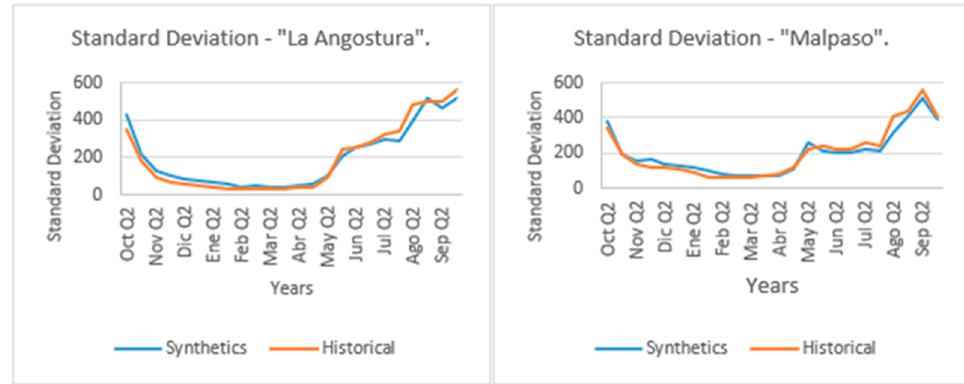
Figure 5. Comparison of standard deviation and average of the 10 synthetic series vs. historical series of La Angostura and Malpaso Dams.